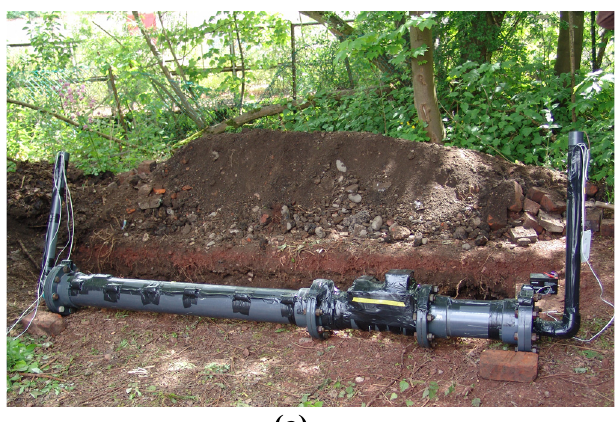
Figure 6. The smart pipe demonstrator unit (a) prior to placement in the 0.8 m deep trench and (b) placed in the trench ready for backfilling